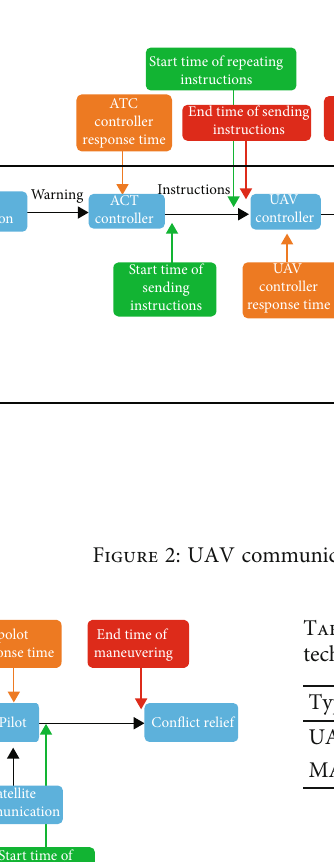
Figure 1: Shared airspace communication diagram.